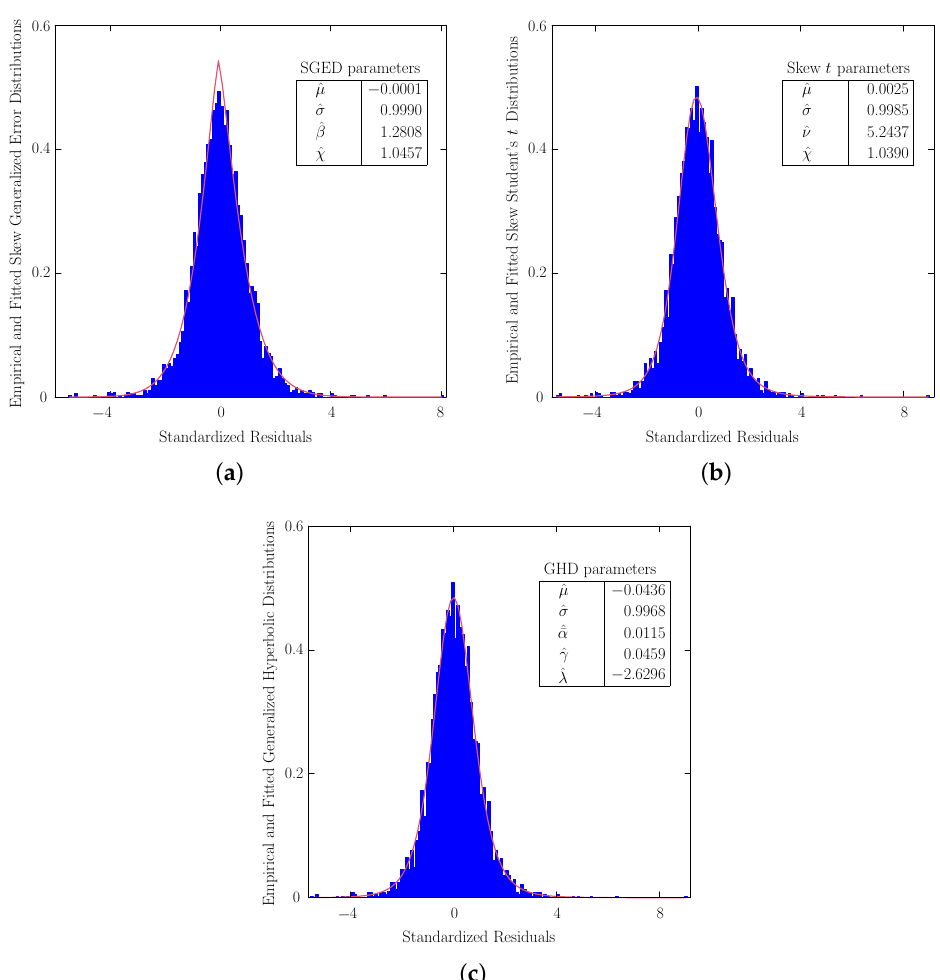
Figure 5. Empirical and fitted theoretical distributions of standardized residuals ˆ ν t . Note: We apply the maximum likelihood method for standardized residuals ˆ ν t from volatility models assuming SGED, skew Student’s t , and GHD in order to obtain parameter estimates of theoretical